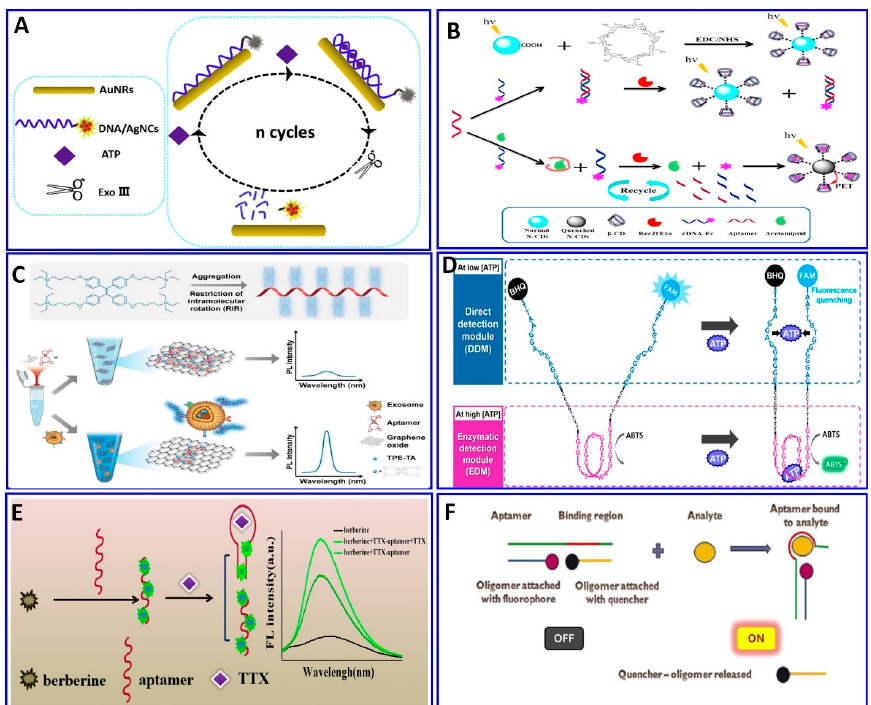
Figure 8. ( A ) Schematic illustration of the ATP assay via quenching of DNA/AgNCs by AuNRs functionalized with aptamer and Exo III for signal amplification, reproduced from [152]. ( B ) Fluorometric assay for acetamiprid using exonuclease integrated with the aptamer protocol, reproduced from [154]. ( C ) Exosomal assay based on the AIE mechanism using graphene oxide (GO) as a quencher for tertiary amine-containing tetraphenylethene (TPE-TA) dye, reproduced from [121]. ( D ) Dual-mode fluorescent aptasensor using both aptamer and a DNAzyme to assay ATP with two different mechanisms, fluorometric and colorimetric signals, reproduced from [159]. ( E ) TTX assay based on the difference in fluorescence response of the berberine reporter, reproduced from [160]. ( F ) Turn-on fluorescence aptasensor assay for chloramphenicol based on oligomer quencher release, reproduced from [163].